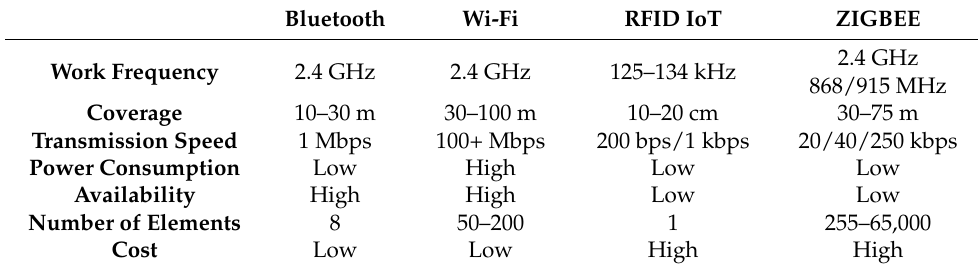
Table 6. Technology comparison for short/medium coverage [33] .